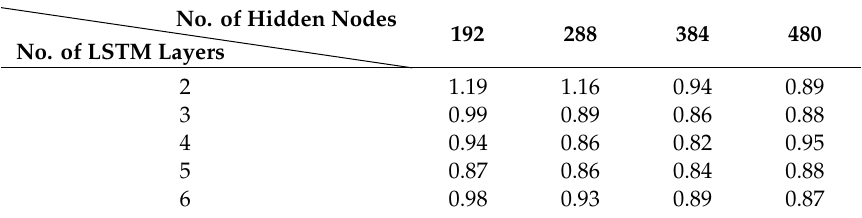
Table 5. Performance comparison of the RMSE of LSTMs for 24 h temperature prediction according to di ff erent numbers of LSTM layers and hidden nodes, where the proposed LSTM-based refinement function was applied (Training data: November 1981 to December 2014, Test data: January 2015 to December